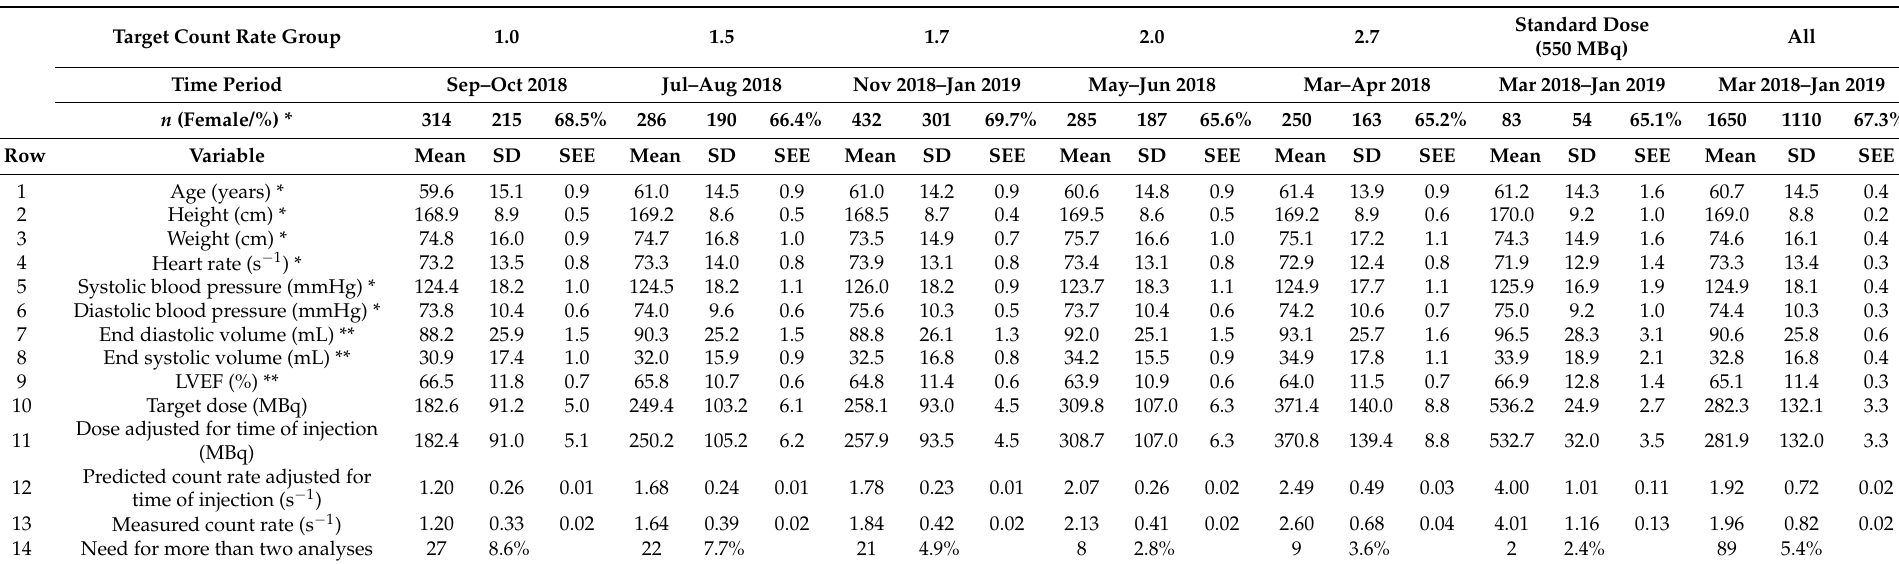
Table 2. Anthropometric data, cardiac variables, dosage information, and frequency of need for more than two analyses depending on target count